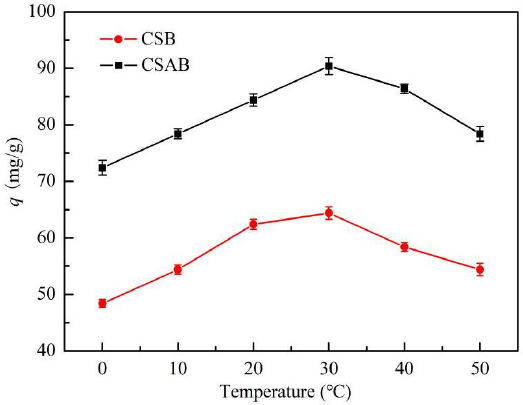
Figure 7. Effect of temperature on adsorption of diesel oil onto biochar.